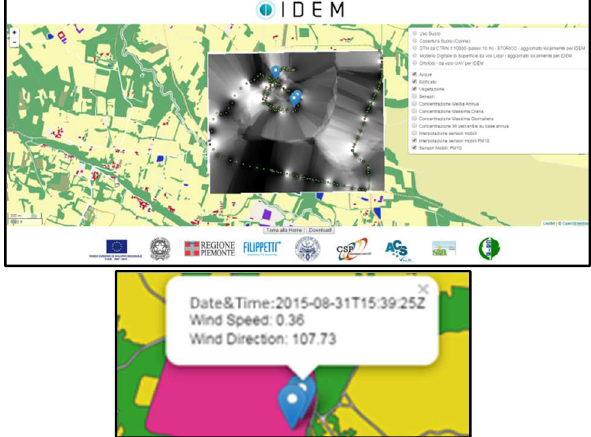
Figure 8: The WebGIS with topographic features, mobile sensor data and related interpolation analysis over the area of SIA Living Lab. The part below shows one of the marker, representing an environmental sensor with its popup content (a new message every minute comes from the platform to update